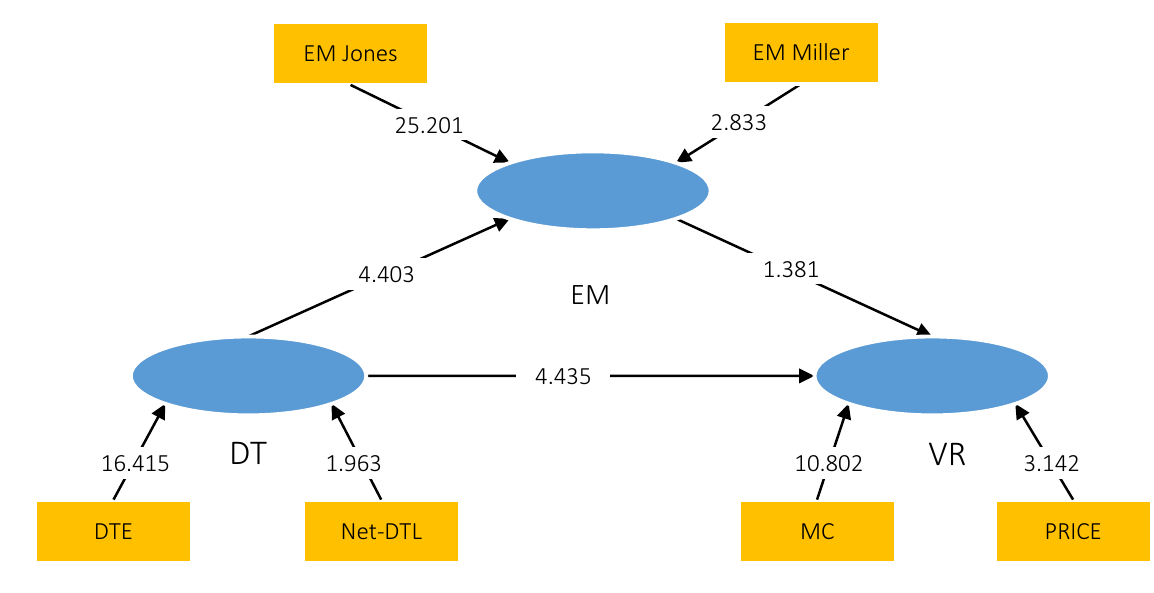
Figure 3. Structural model (inner model)